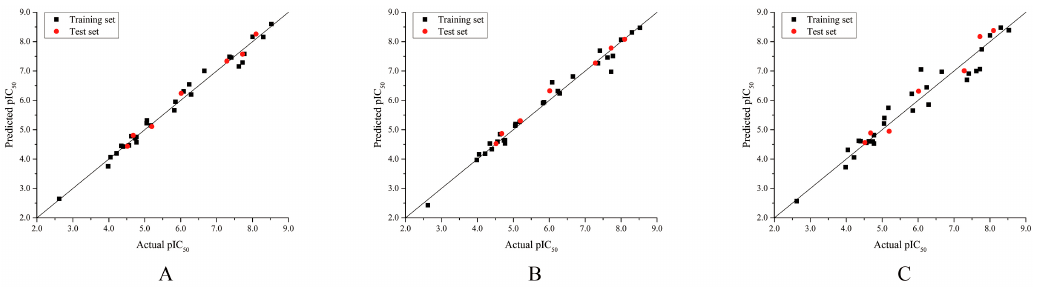
Figure 3. Plot of actual pIC 50 against predicted pIC 50 by the optimal CoMFA ( A ), CoMSIA ( B ), and Topomer CoMFA ( C ) models.